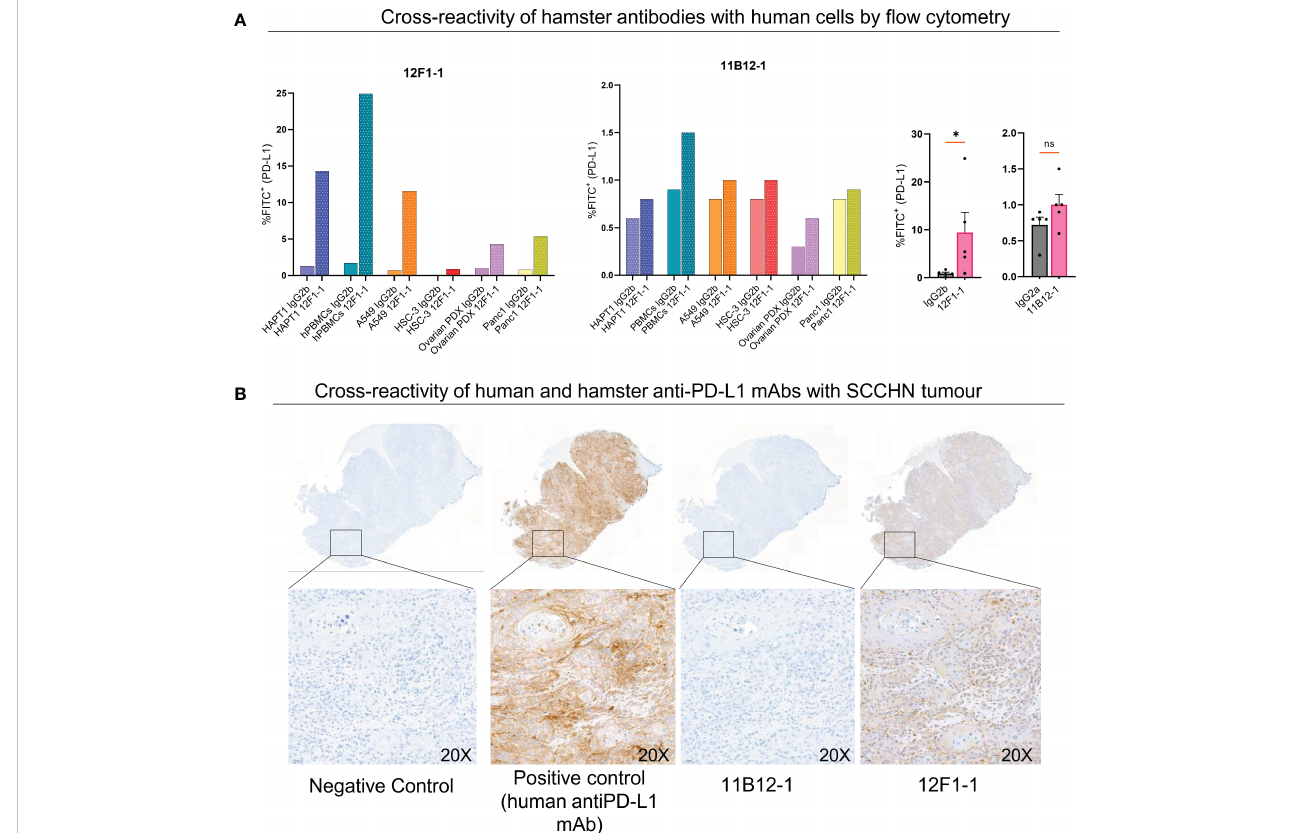
FIGURE 6 Cross-reactivity of 11B12-1 and 12F1-1 with human samples. (A) Evaluating cross reactivity of 11B12-1 and 12F1-1 with four human cancer cell lines (A549, HSC-3, Ovarian PDX and Panc 1), human PBMCs and hamster cancer cell like (HaptT1) by fl ow cytometry. Percentage of FITC + was used as a readout and each stain compared with respective isotype control. (B) Immunohistochemistry staining of patient head and neck squamous cell carcinoma tumour (HUSHN) with 11B12-1, 12F1-1 and anti-human PD-L1 mAb (PD-L1 [E1L3N ® ] XP ® Rabbit mAb). Statistical signi fi cance of fl ow cytometry data was evaluated using an unpaired t-test with Welch ’ s correction. *p < 0.05; ns, not signi fi cant. Error bars are presented as mean ±